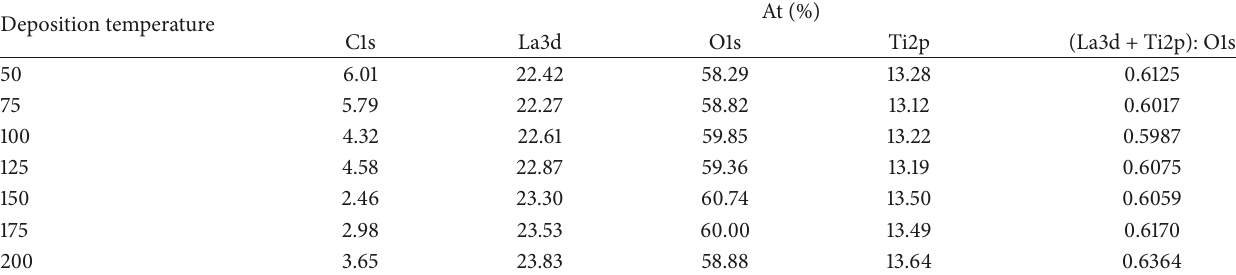
Table 1: Content of elements in the films prepared at different deposition